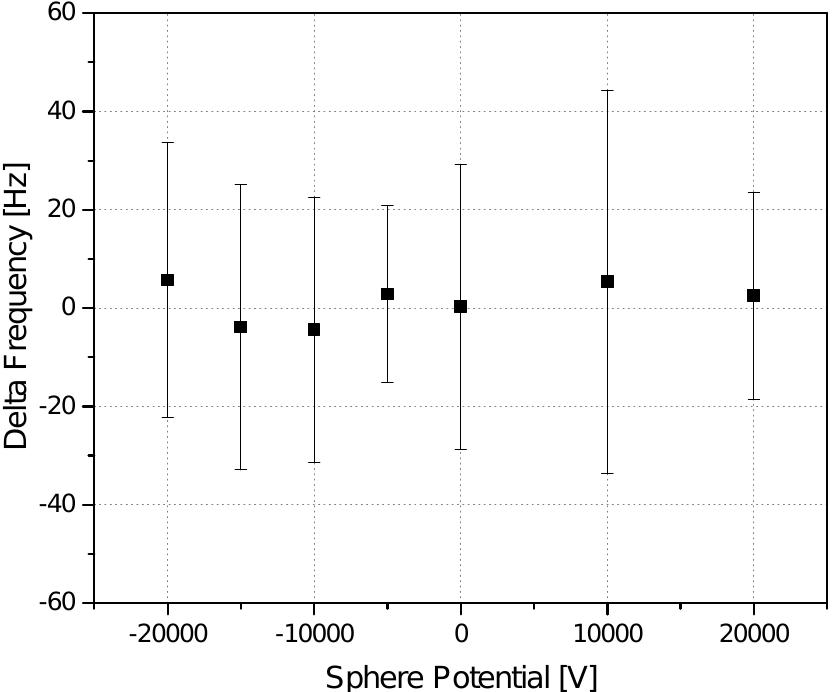
Figure 3. Frequency change versus applied sphere